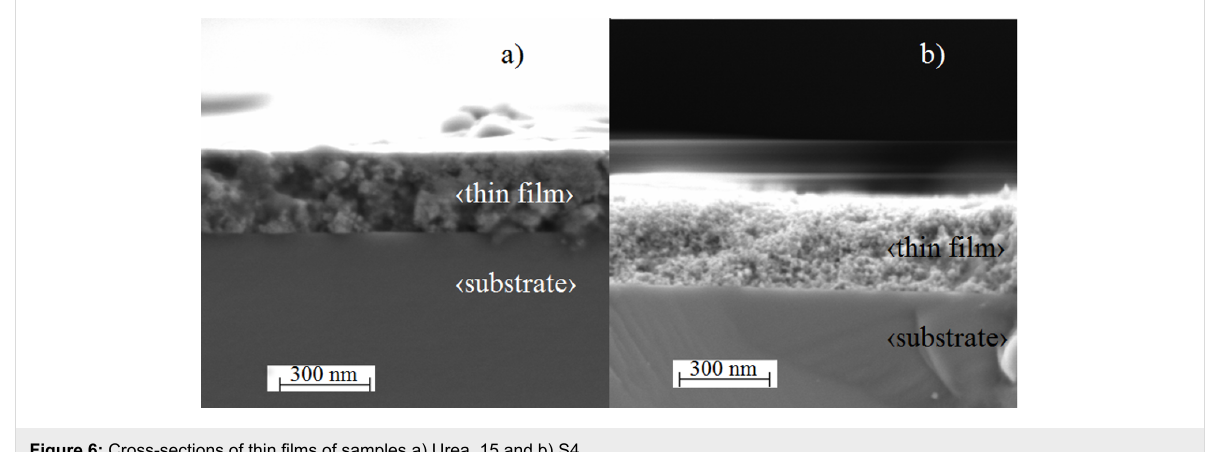
Figure 6: Cross-sections of thin films of samples a) Urea_15 and b) S4.